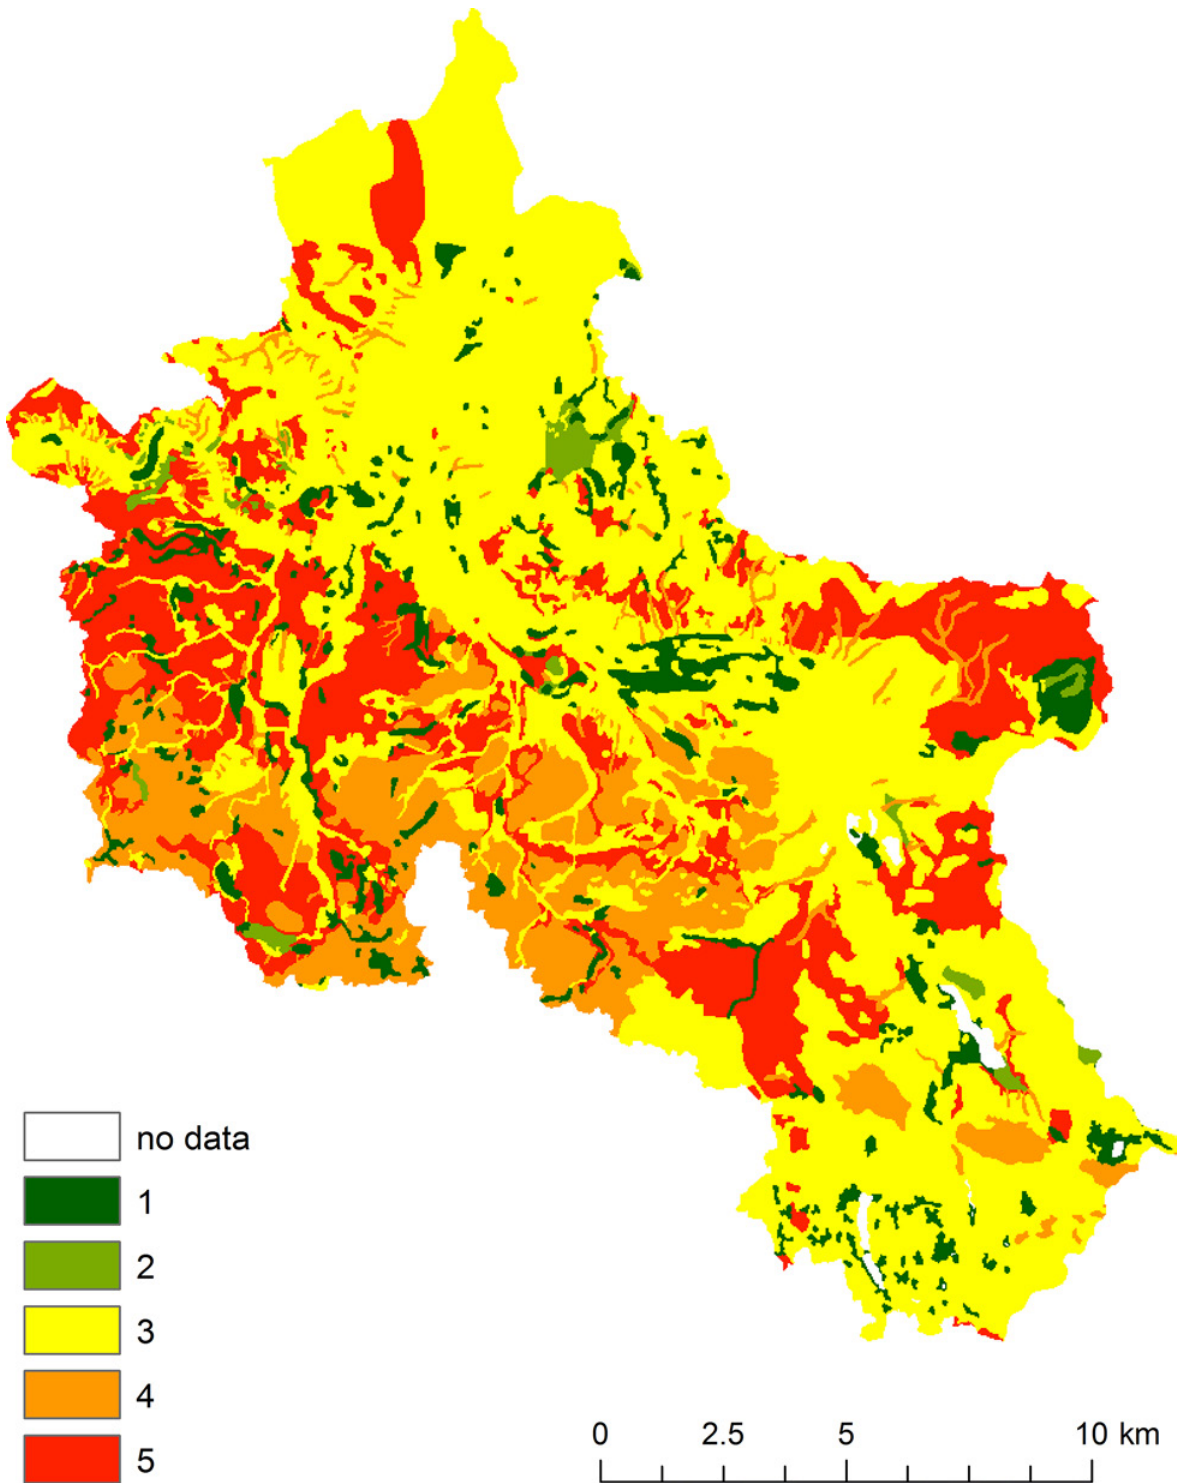
Fig. 3. Factor map of the lithological